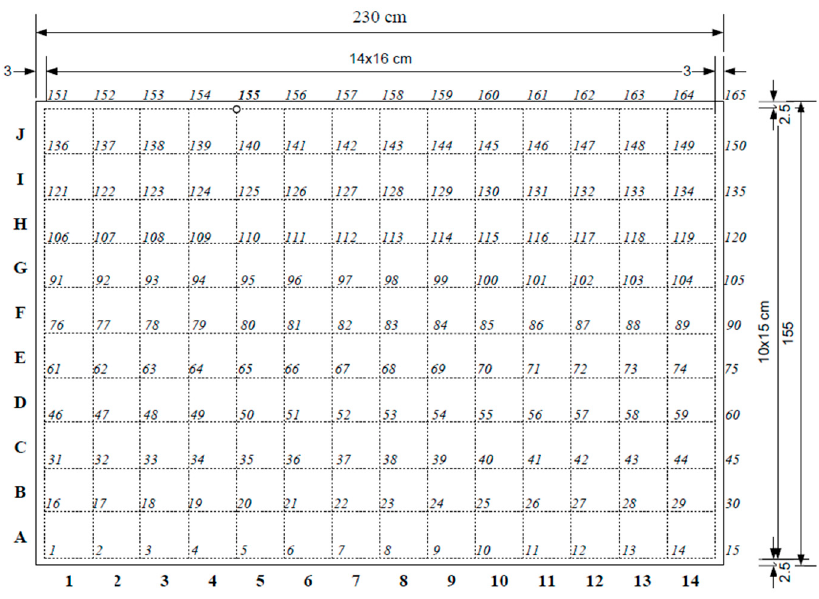
Figure 1. Measurement points on the RC plate.